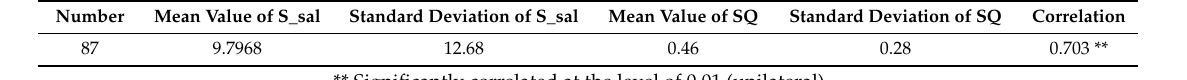
Table 6. Accuracy verification of soil salinization